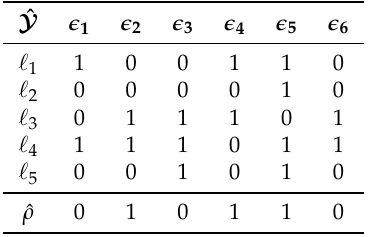
Table 3. Level soft set L ( ˆ Γ ; mid